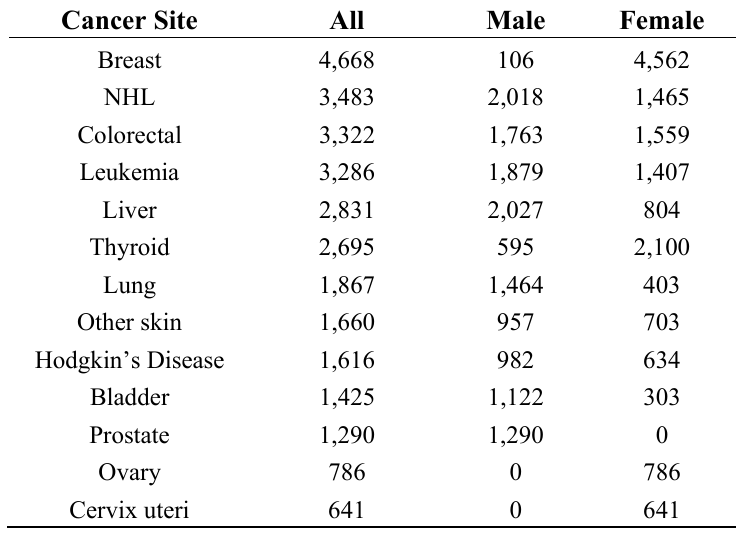
Table 1. Number of diagnosed cases of the most common